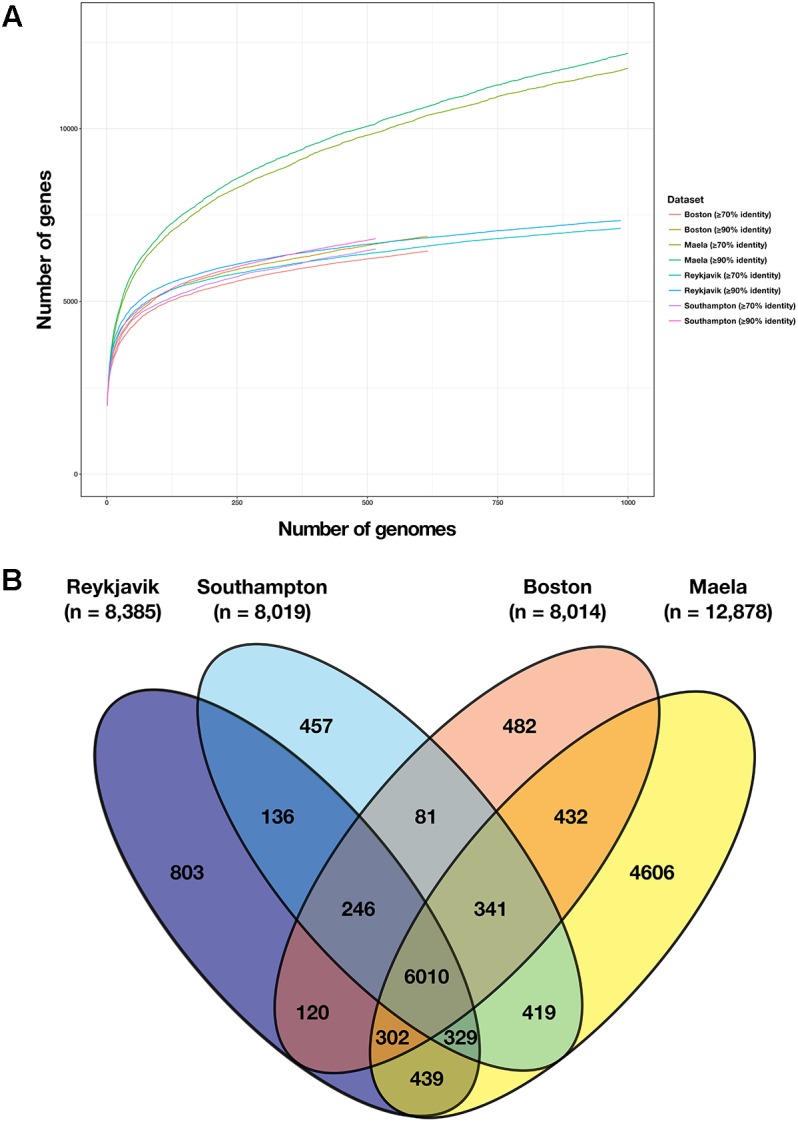
Comparison of the number of genes in the pan-genome of each dataset. (A) Results of Roary pan-genome analyses using two different thresholds, ≥70 and ≥90% nucleotide sequence similarity, for each of the four datasets; (B) Venn diagram depicting the number of genes present in the pan-genome of each dataset and of those, which were shared between datasets (using the ≥70% sequence similarity threshold).